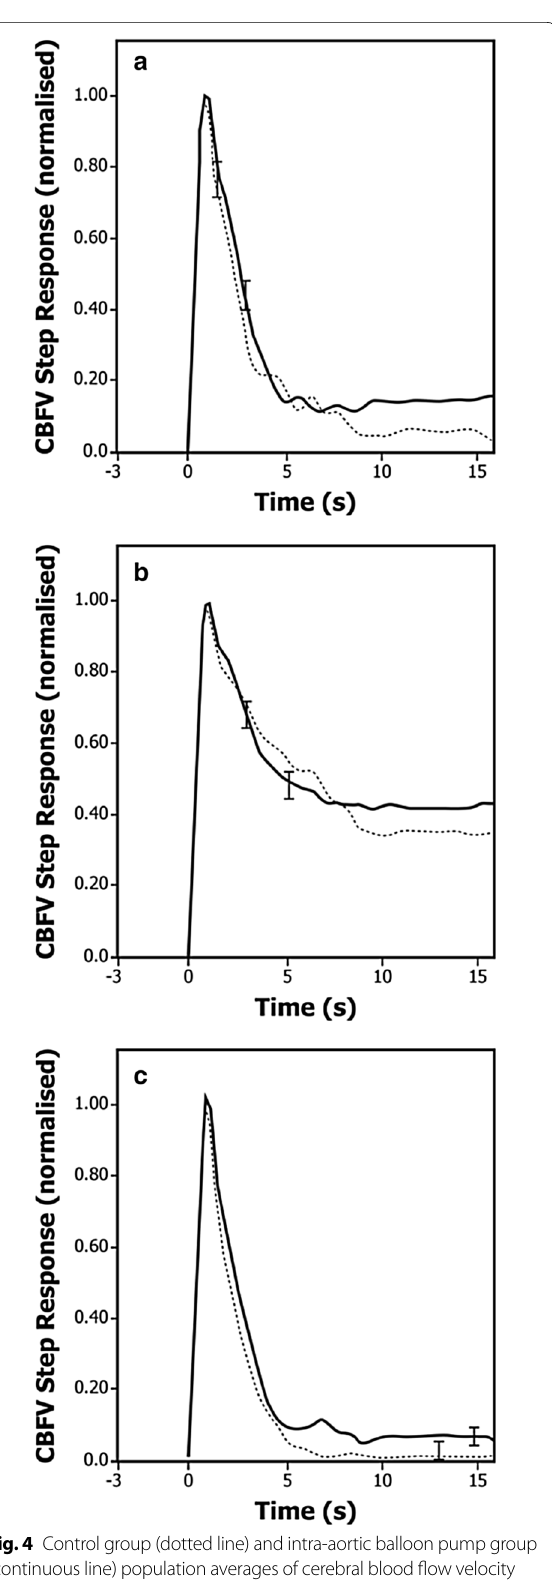
Fig. 4 Control group (dotted line) and intra‑aortic balloon pump group (continuous line) population averages of cerebral blood flow velocity step response. Before surgery ( a ) and 24 h ( b ) and 7 days after surgery ( c ).